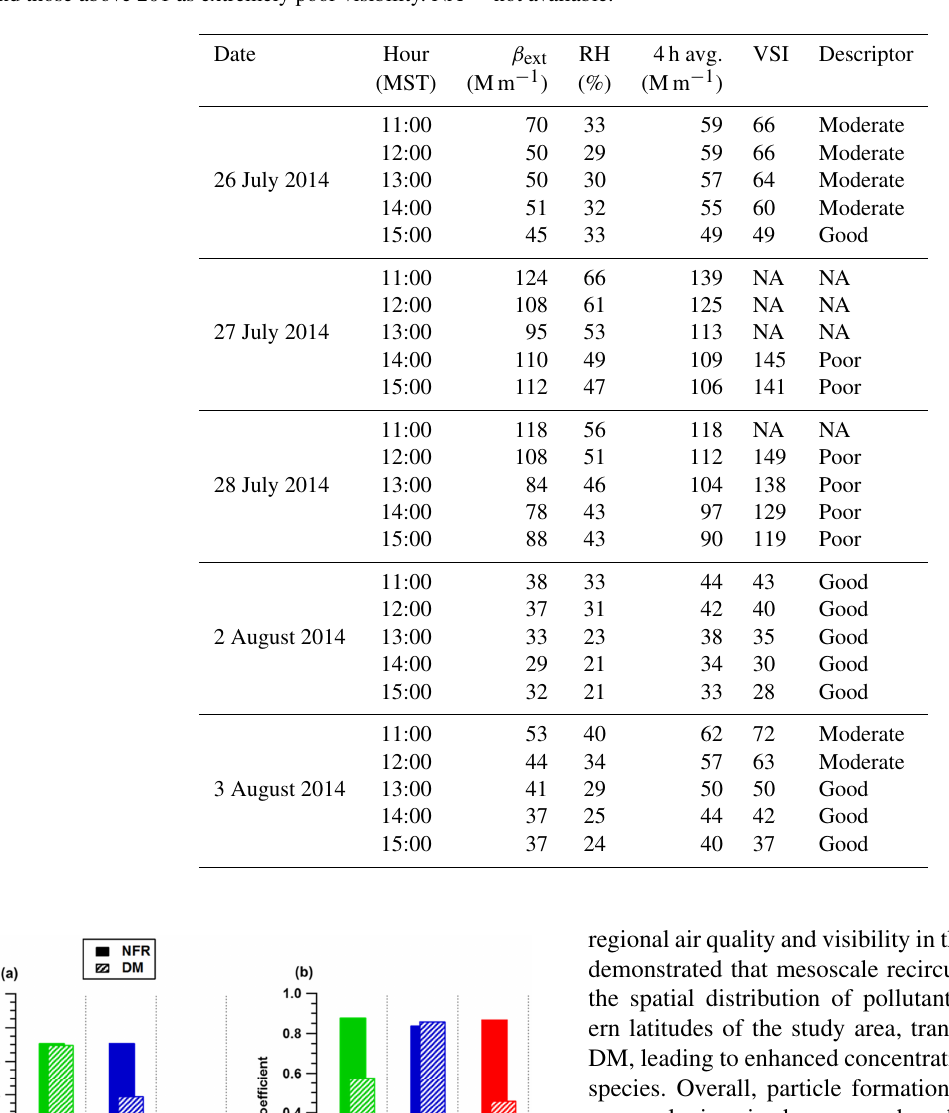
Table 2. Summary table of β ext measurements from the Colorado Department of Public Health and Environment (CDPHE) long-path transmissometer in downtown Denver for each of the 5 days of interest. On the Visibility Standard Index Scale, a value of 101 equates to 76Mm − 1 standard. Values between 0 and 50 are described as good, those between 51 and 100 as moderate, those between 101 and 200 as poor, and those above 201 as extremely poor visibility. NA = not available.